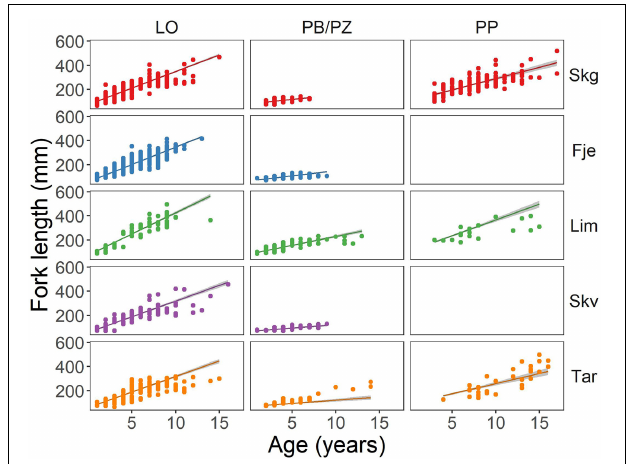
FIGURE 2 | Scatter plot of Arctic charr fork length (mm) at age for each morph type within each lake included in the study. The model is represented by a line with shading representing the 95% confidence interval. Skg, Skogsfjordvatn; Fje, Fjellfrøsvatn; Lim, Limingen; Skv, Skøvatn; and Tar, Tårnvatn.